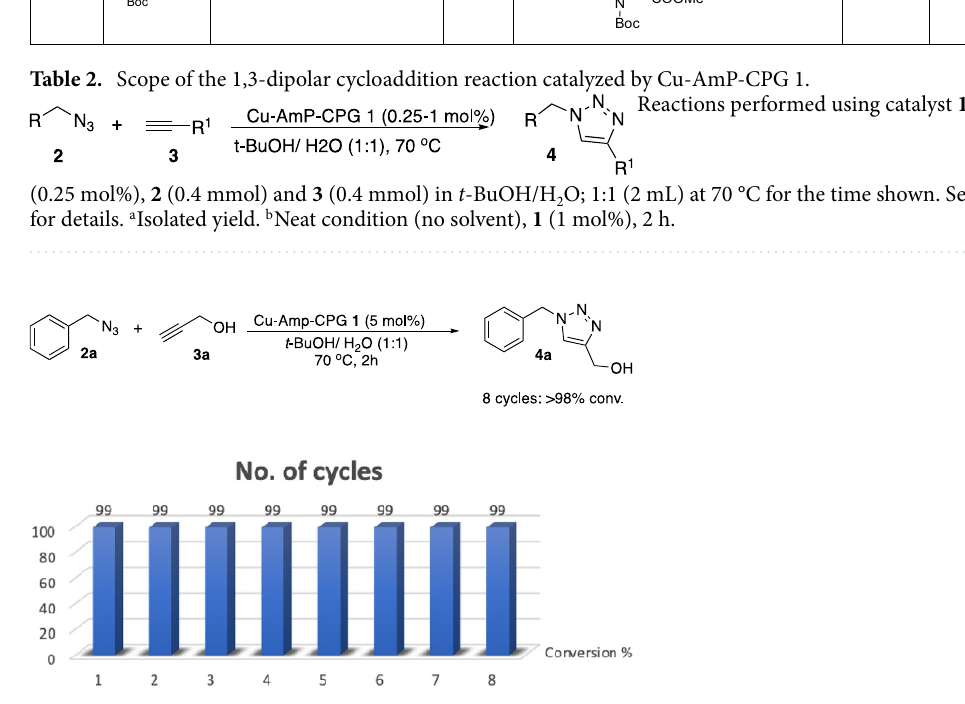
Figure 2. Recycling experiments of Cu-AmP-CPG 1 -catalyzed 1,3-dipolar cycloaddition between benzyl azide 2a and propargyl alcohol 3a . Conversion to 4a .